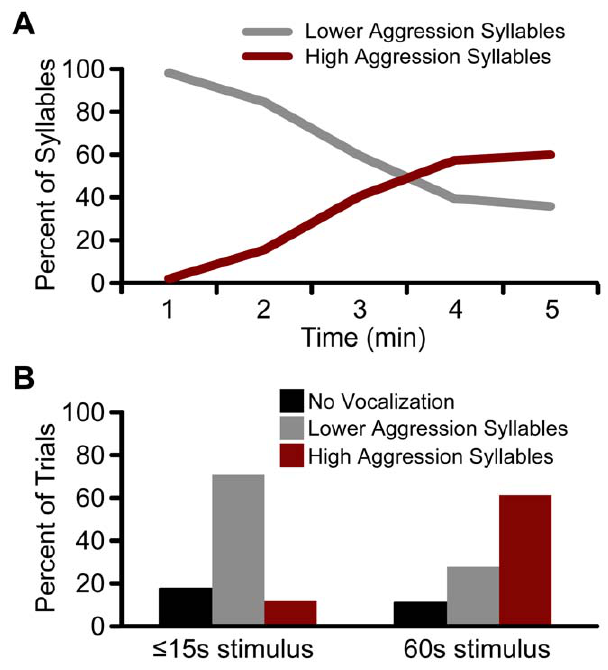
Figure 8. Prolonged tactile stimulation evokes high aggression syllables. ( A ) Example data from a single bat during a 5-min trial of tactile irritation. The bat began emitting lower aggression syllables (i.e. DFMs and DFMm) but later transitioned to high aggression syllables. ( B ) Short duration ( # 15 s) tactile stimulation at a rate of , 1/sec was more likely to elicit lower aggression syllables, whereas a longer duration of stimulation (60 s) evoked high aggression syllables.